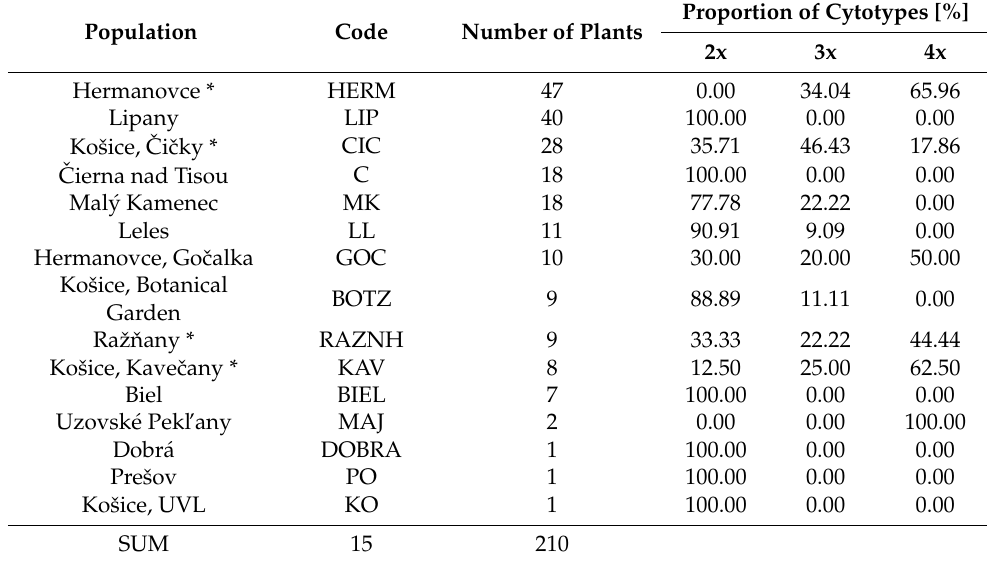
Table 1. Cytotypic diversity in 15 populations of Crataegus in eastern Slovakia irrespective of taxa affiliation [78]. Populations marked with asterisks indicate the source populations for triploid mother trees investigated using the FCSS. Populations were selected to sample various morphologically diverse taxa, especially triploids, and to include those accessible individuals that produced a consid- erable number of fruits available for